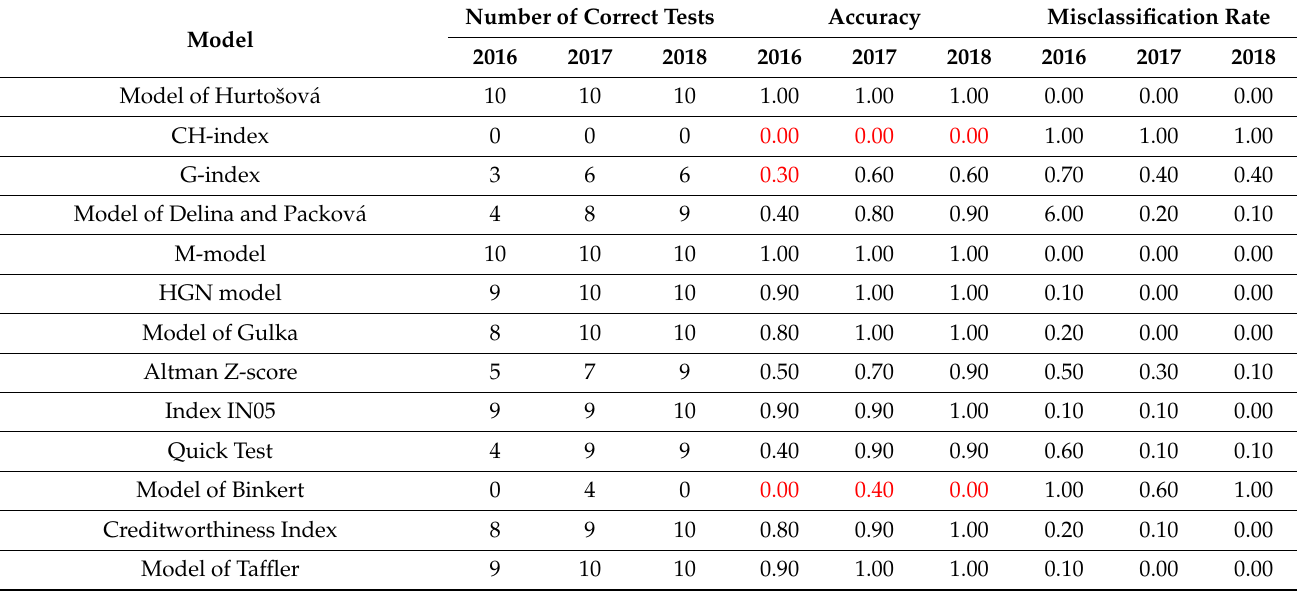
Table 5. Results of testing default prediction models on prosperous companies in construction sector in 2016–2018.